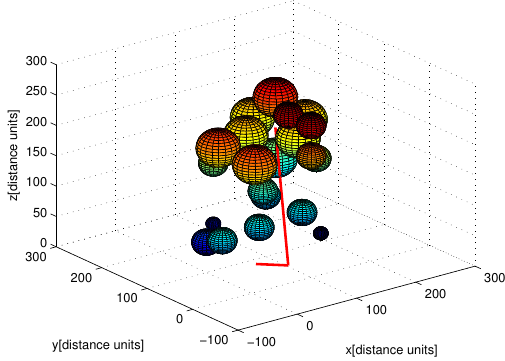
Figure 4. The path constructed utilizing one MC simulation of Algorithm 1. The obstacles are shown as spheres. The generated path is depicted with red line